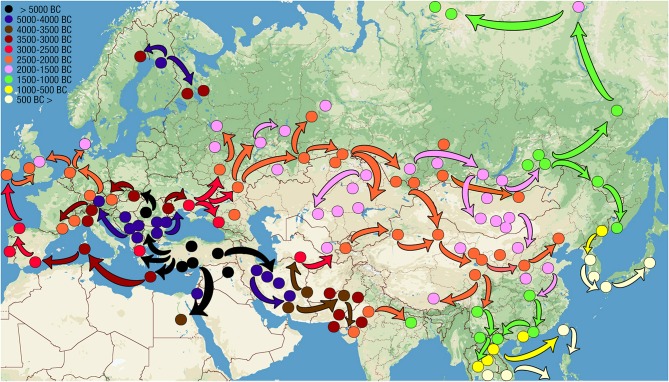
Historic spread of copper metallurgy in Eurasia. This map displays the locations of earliest regional centers of smelting copper ores—according to the available archaeological research on the earliest metallurgy (Chernykh, 1966, 1992, 2012; Sunchugashev, 1975; Zhuravlev, 1977; Sergeyeva, 1981; Prakash and Tripathi, 1986; Rybakov, 1987; Kon'kova, 1989; Thiel, 1989; Mishra, 1994; Reedy, 1997; Kiriushin, 2002; Tylecote, 2002; Nguyen, 1986; Baipakov and Taimagambetov, 2006; Simukhin, 2006; Yanin, 2006; Ciarla, 2007; Hauptmann, 2007; Kaniuth, 2007; Park and Gordon, 2007; Subbotina, 2008; Herva et al., 2009; Roberts et al., 2009; White and Hamilton, 2009; Radivojević et al., 2010; Erb-Satullo, 2011; Higham et al., 2011; Wan, 2011; Potts, 2012; O'Brien, 2014; Garner, 2015; Gelegdorj, 2015; Mei et al., 2015; Hung and Chao, 2016; Huo, 2016; Tripathi, 2018). The routes and timeline of its spread suggests the spread of metallic JHs along with the new homophonic tradition of JH music. The timeline is indicated by color-coding of the circle-icons that mark the location of smelting sites: the darker—the older. The epicenter of metallurgy is in modern Turkey and Iraq, although a concurrent independent center might have existed in Vinca culture, in Balkans, Belovode (Radivojević et al., 2010). Anther independent center emerged in Fennoscandia (Herva et al., 2009) and the neighboring Karelia (Zhuravlev, 1977). Copper metallurgy spread from Balkans to Ukraine, thereon bifurcating, with one branch heading to the northeast forest zones of Russia (up to Ural Mountains), while the other moving southeast through the Steppe Belt all the way to Zabaikalye and Mongolia. There, again the route bifurcated: north, going to Yakutia, and south to Primorye. The other wave from the epicenter reached Iran, branching in 3 directions: toward Indus' valleys, Himalayas, and Middle Asia, through Turkmenistan, Uzbekistan and Kazakhstan to the Uyghur territories via the route that later became known as the Silk Road (Kuzmina, 2008). Around Lop Nor this branch met the outshoot of the Steppe Belt route and proceeded through modern China to its North and South kingdoms. The southern branch eventually hit Indochina, then heading to Indonesia and Pacific islands. This entire area, Manchuria and Japan were the last to develop metallurgy—no earlier than in Middle Ages. Therefore, if for Volga-Ural area frame-shaped JHs co-evolved with the metallic JHs, for cultures at the eastern end of Eurasia bow-shaped JHs came from West and formed its own special niche, different from the already established frame-shaped JH cultures. The bow-shaped tradition must have taken a long time to develop—as metallic artifacts were becoming more affordable to local population. Another zone where frame- and bow-shaped JHs form different cultural traditions is the vast area from southeastern Indochina to Papua New Guinea. The two zones where metallic bow-shaped JHs must have penetrated concurrently with organic frame-shaped JHs where both might have shared the same or similar forms of use, are Himalayas-Pamir-Tian-Shan mountains and Yunnan-Myanmar area.